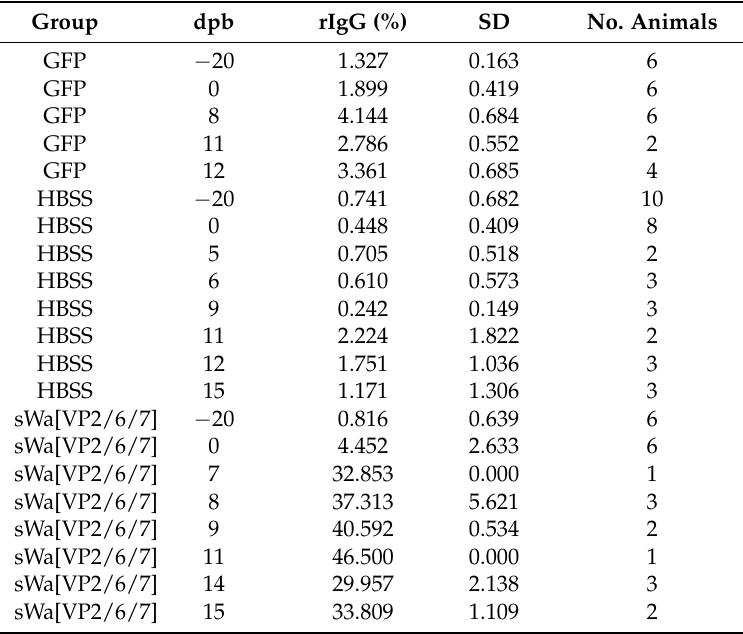
Table A6. This table shows the relative IgG values of serum samples of the dams from experiment 2. These dams raised the pups further analyzed in Figure 3E.